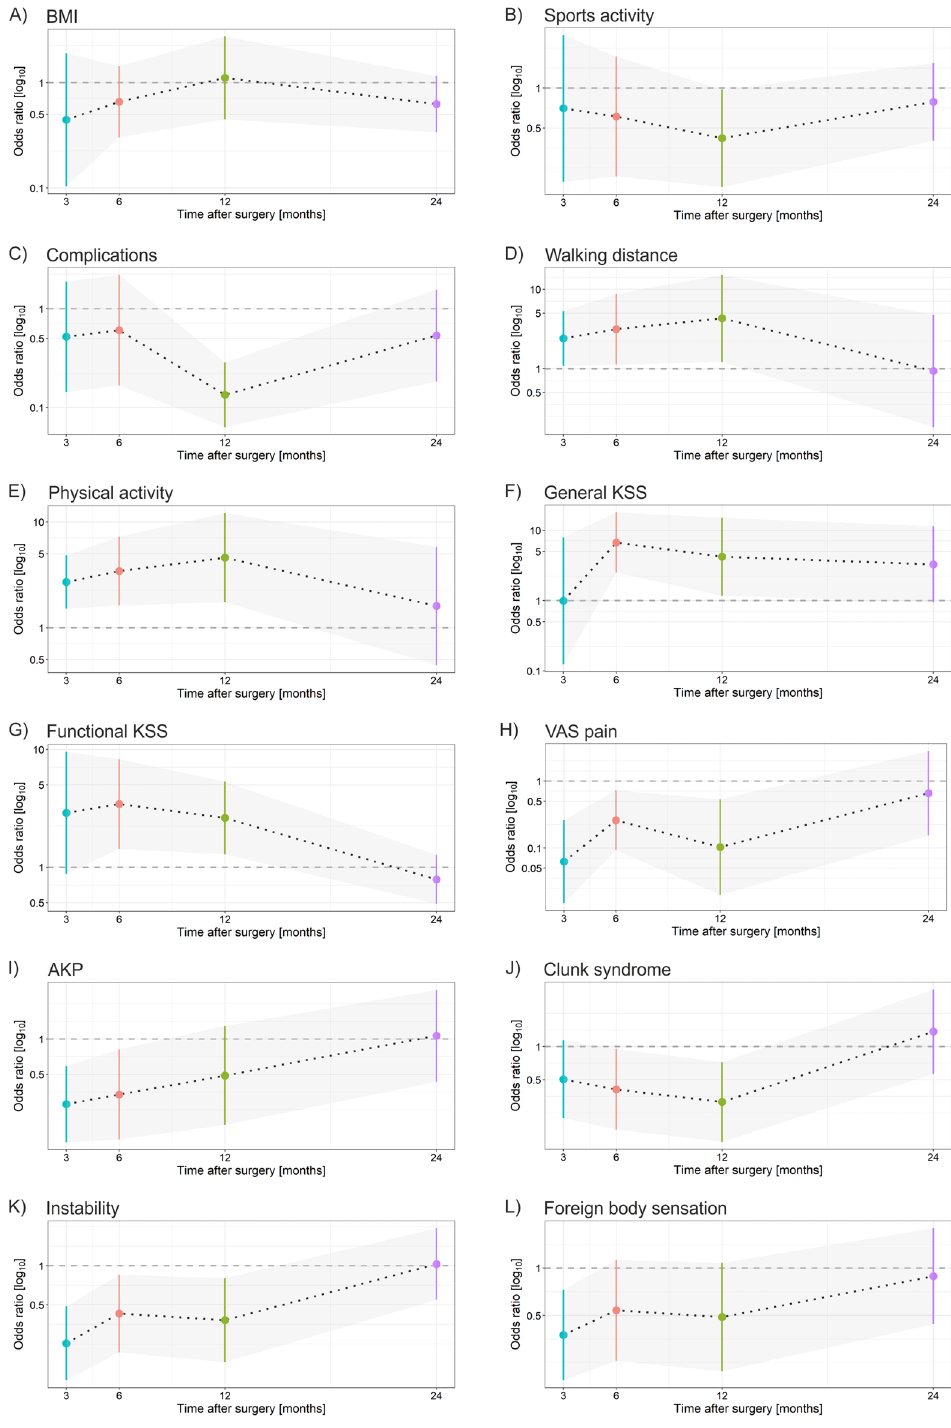
Figure 1. Contribution of postoperative factors to the likelihood of satisfaction in women in the 2 years after TKA. ( A ) BMI, ( B ) sports activity, ( C ) complications, ( D ) walking distance, ( E ) physical activity, ( F ) general KSS, ( G ) functional KSS, ( H ) VAS pain, ( I ) AKP, ( J ) clunk syndrome, ( I ) instability, ( K ) foreign body sensation. Odds-ratio (marked by dots) values above 1 are associated with satisfaction; values below 1 are associated with not being fully satisfied. The bars represent odds ratios (95%CI, low–high